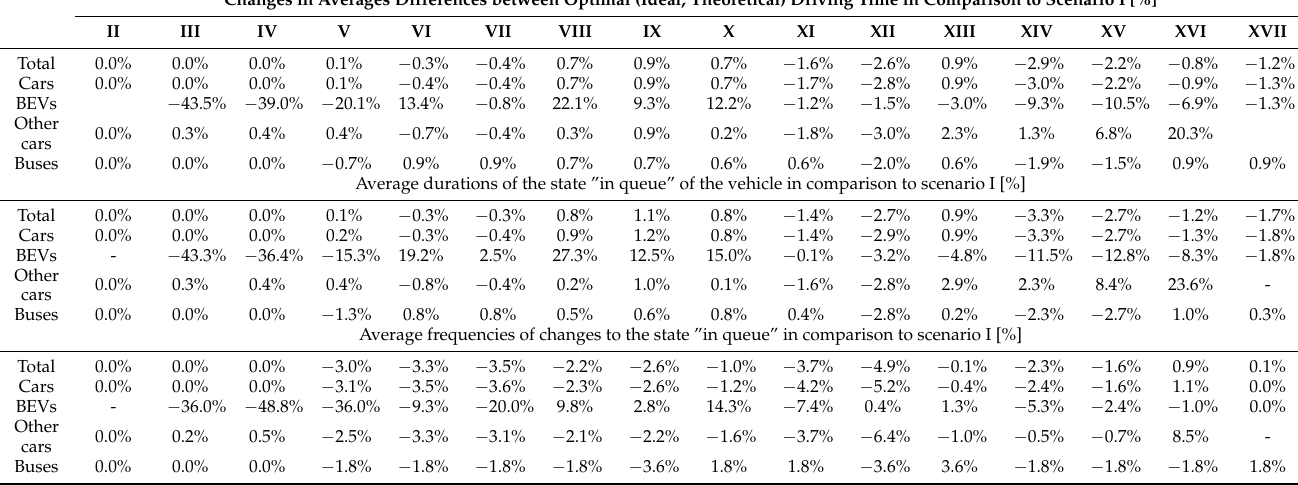
Table 6. Changes in selected traffic parameters in comparison to (base) scenario I for the total number of vehicles and their individual